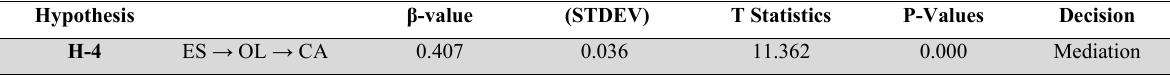
Mediations (indirect effect) Results